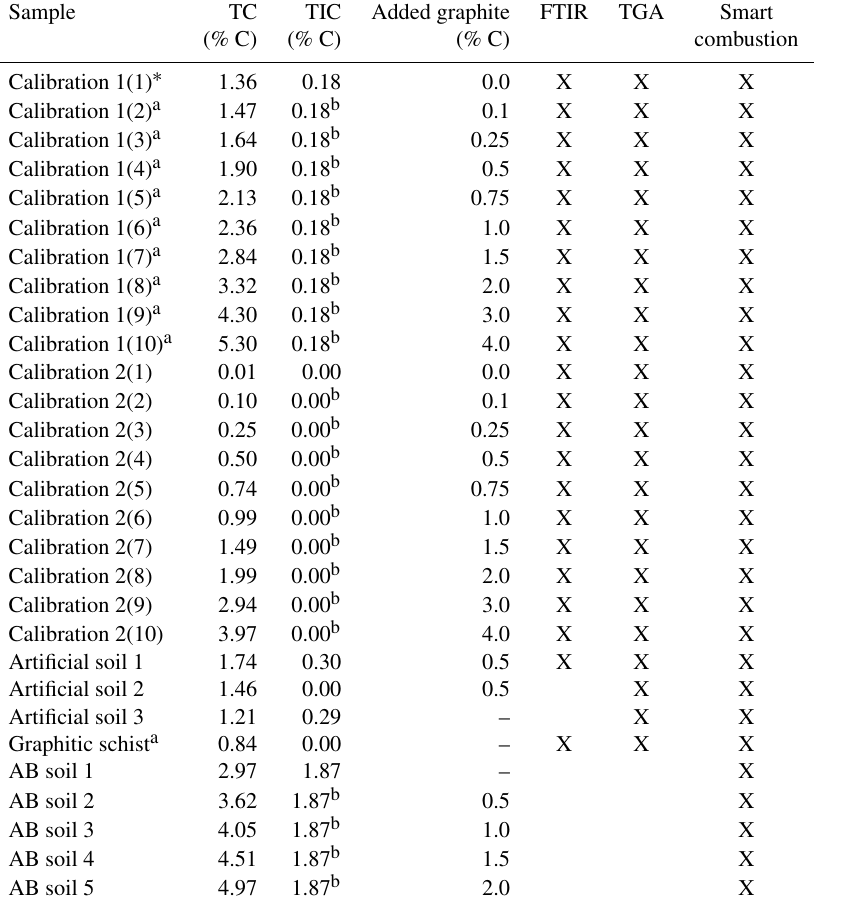
Table 1. Overview of the used samples. Total carbon (TC) and total inorganic carbon (TIC) data are derived by the elemental analyser, as described in Sect. 2.1. Crosses note for which method testing the sample has been